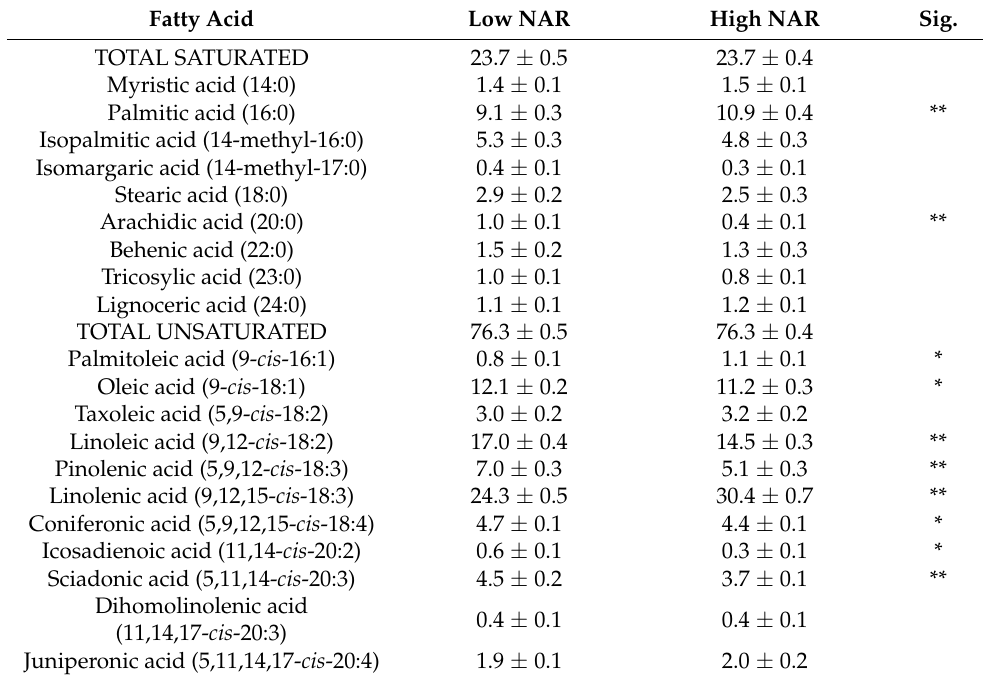
Table 1. Fatty acid relative percentages in balsam fir needles from low and high needle abscission resistance genotypes of balsam fir collected initially in September to establish a baseline fatty acid profile at the beginning of the experiment. Relative percentages are displayed as mean ± standard error as calculated from 20 branches. An * indicates 1–5% significance while ** indicates less than 1% significance.